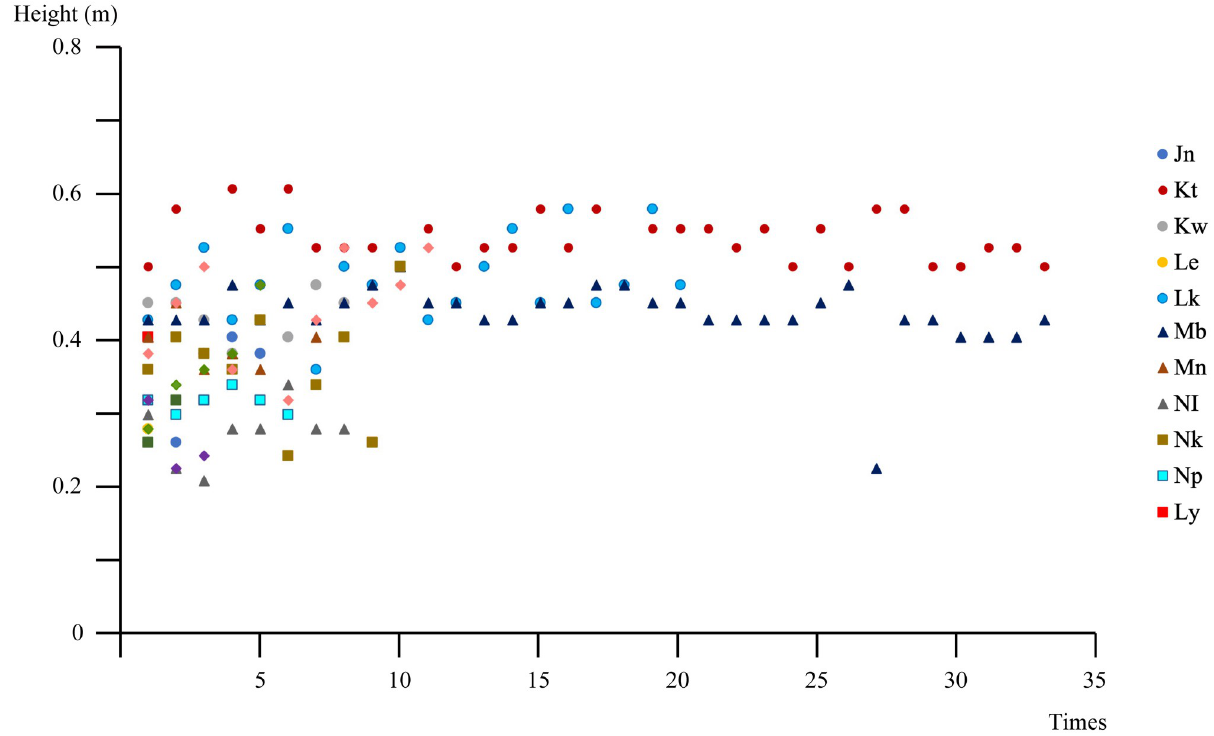
Fig 2. Distribution of BCOM heights for each jumper. (n = 155).